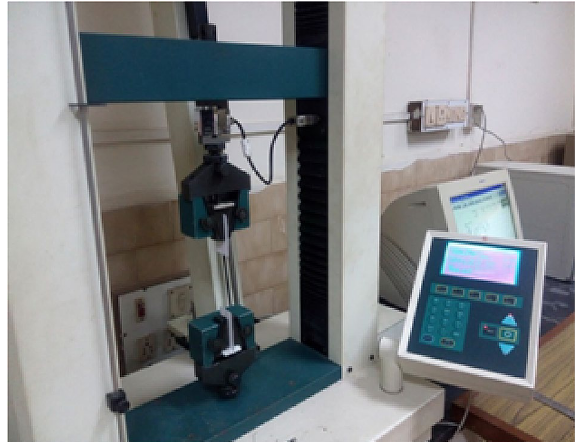
Fig. 3 Arrangements of single fiber tensile